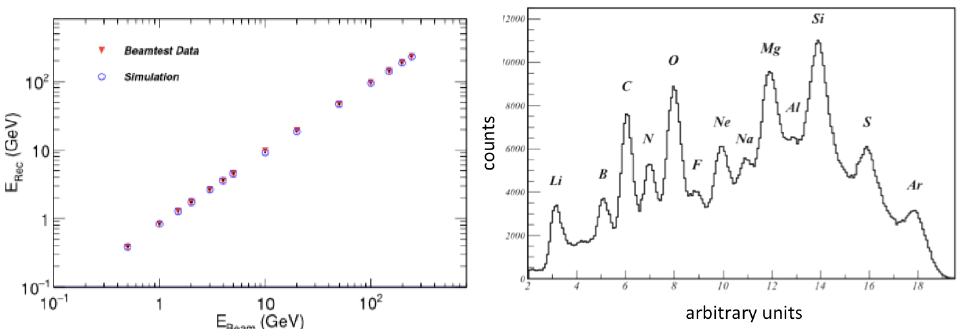
Figure 3. Beam test - PSD charge spectrum of fragments of an argon beam (helium peak has been